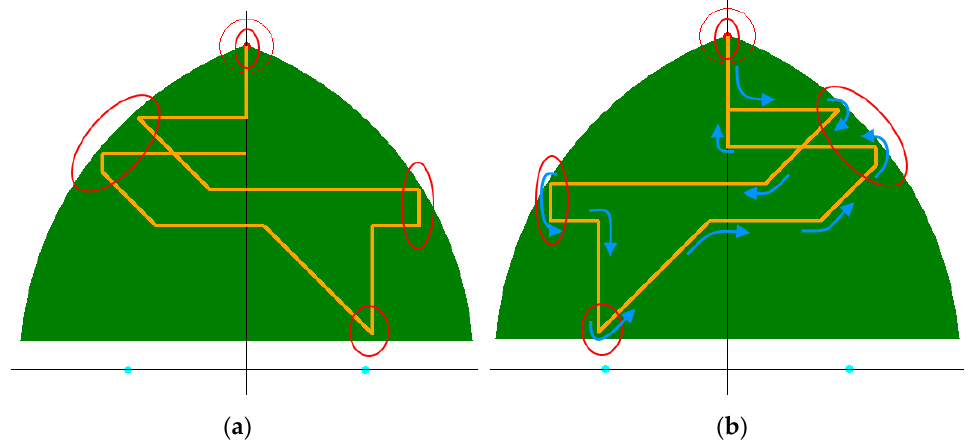
Figure 3. The trajectories (in orange) used in task three ( a ) and used in task four ( b